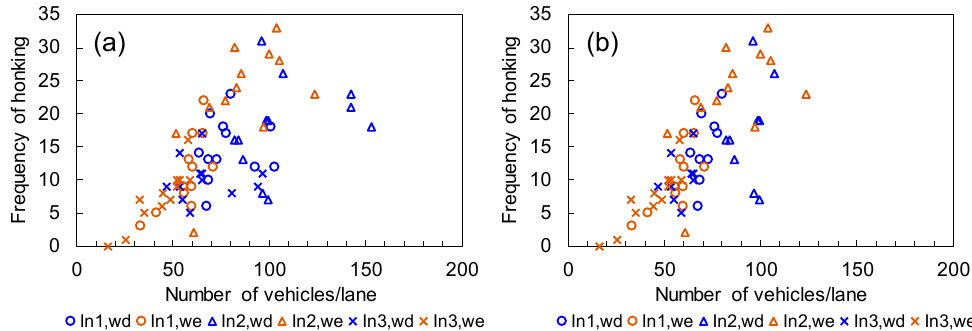
Figure 5. Relationship between the traffic volume per lane and frequency of horn use. ( a ) Data of all measurement times. ( b ) Data without measurements during rush hours on weekdays.